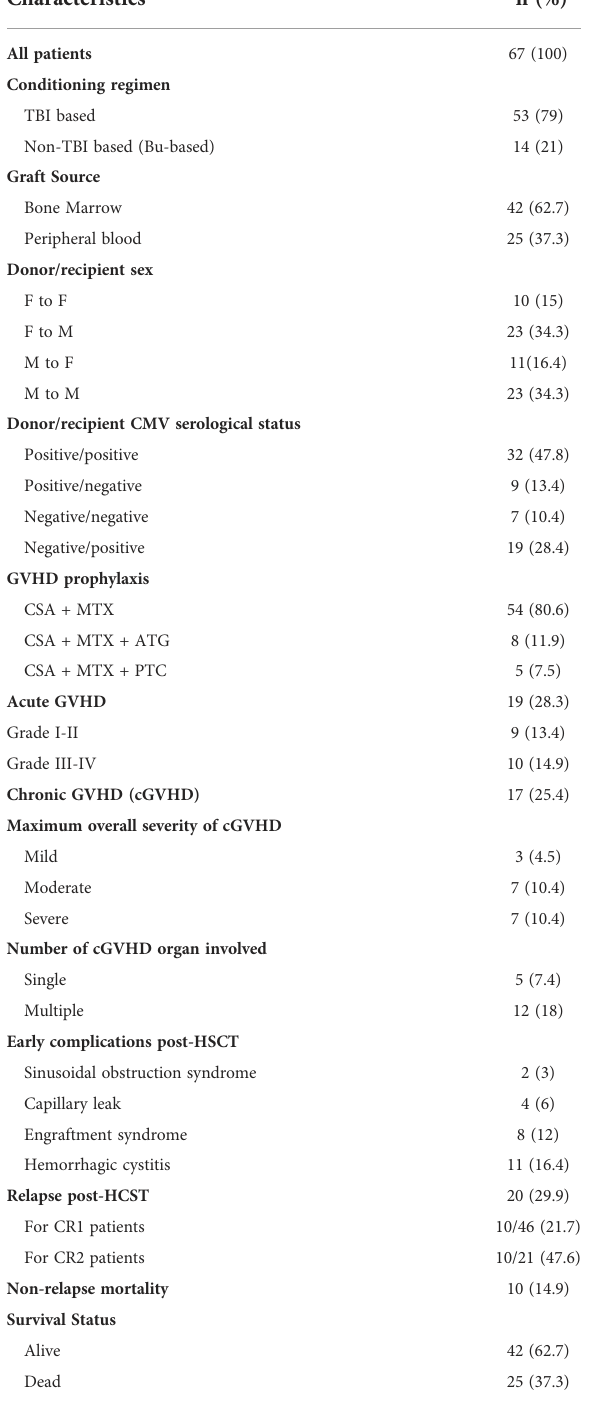
TABLE 3 Transplant details and outcomes of the 67 ALL